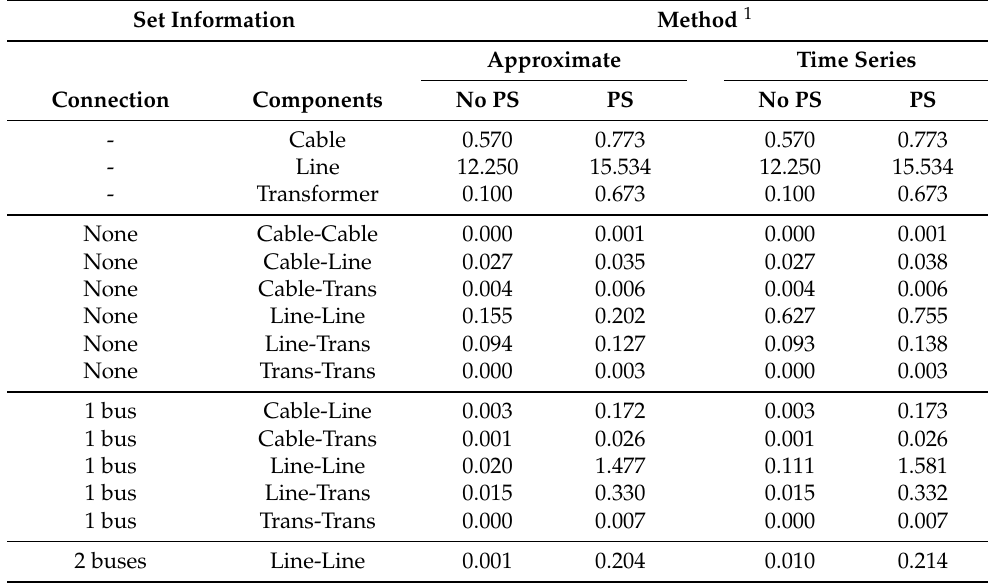
Figure 6. Individual failure probability of components in cut-set {26, 27} and dependency mode failure probability for a 40 hour time-window. Failure probability and unavailability of cut-set, including and excluding protection system failures. Table 1. Annual failure rate for outages within different set categories [ λ / y